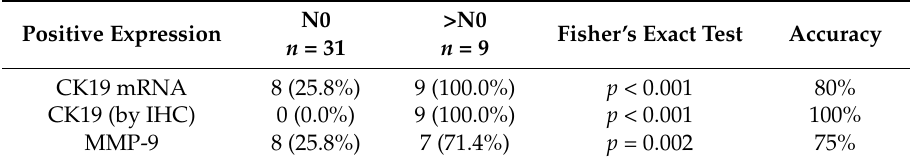
Table 2. Correlation between expression of CK19 mRNA, CK19 (by IHC) and MMP-9, and nodal status.